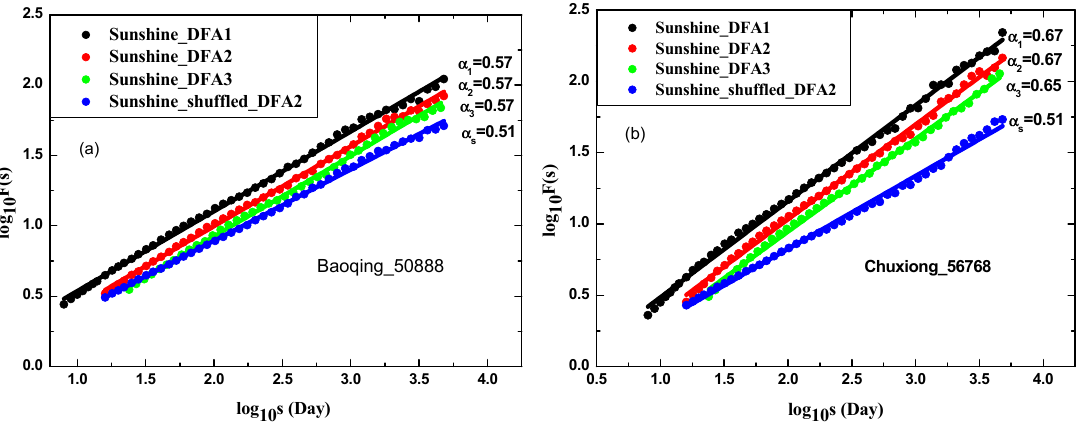
Figure 3. The log-log plots between the detrended variability F ( s ) and the time scale s before and after shuffling two SSDA records at ( a ) station Baoqing. ( b ) staion Chuxiong. Solid lines are a linear fit.